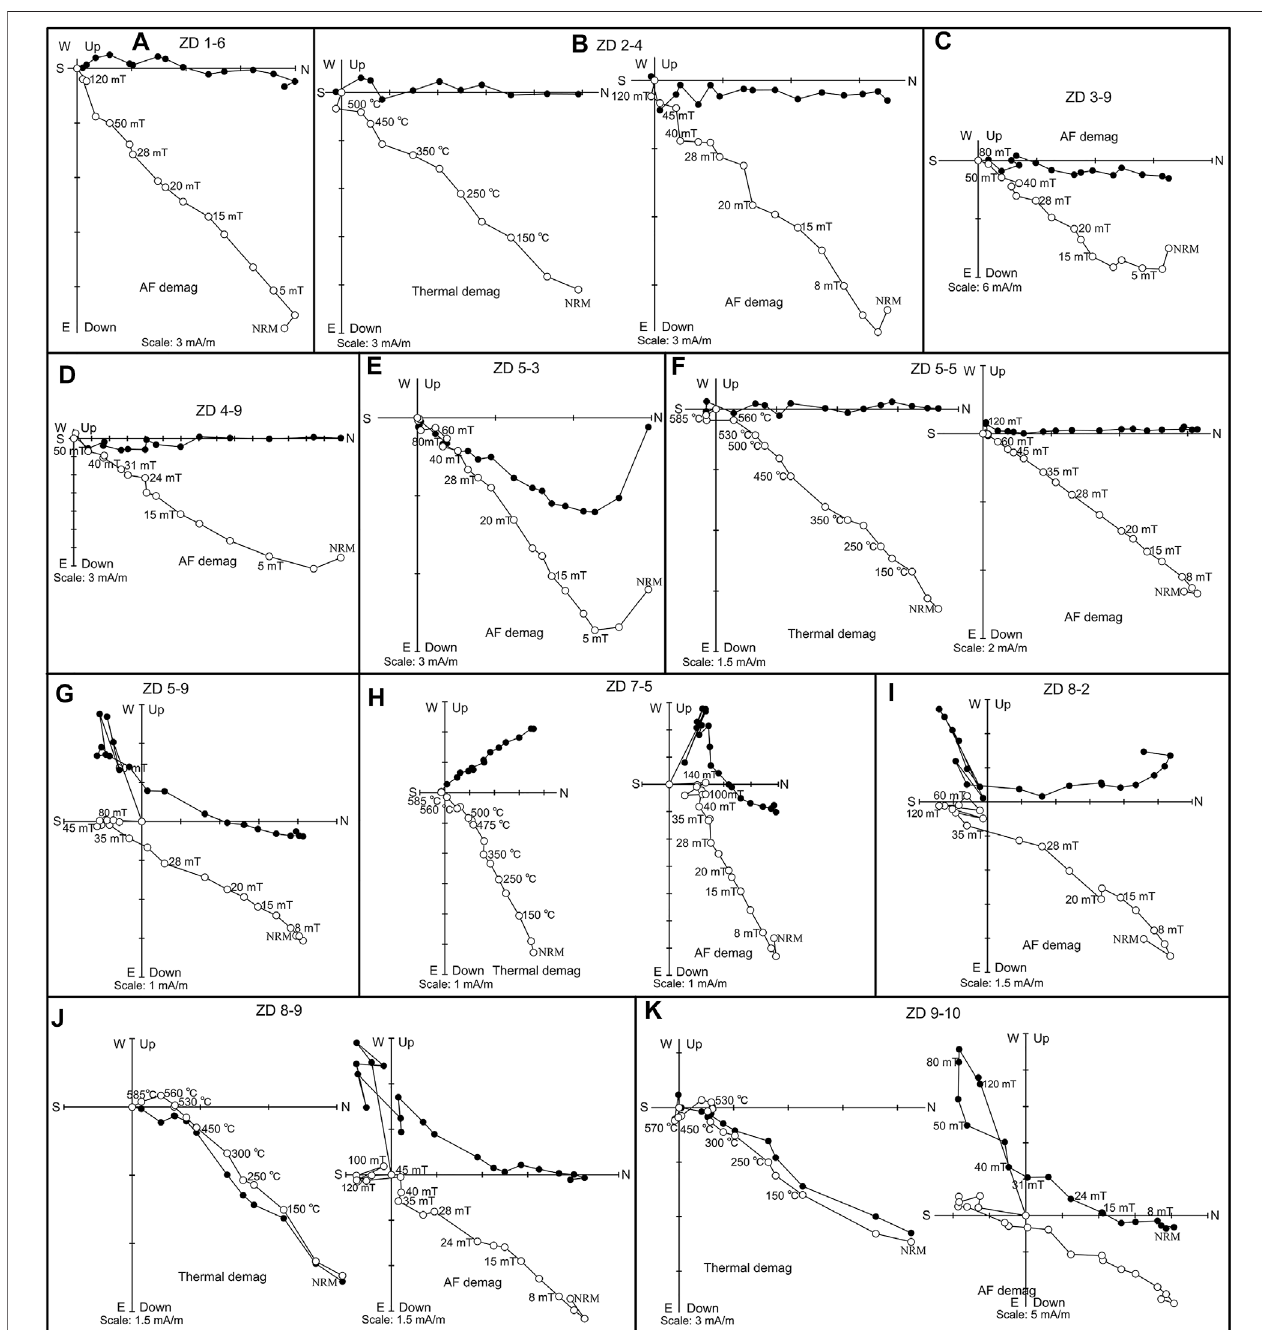
FIGURE 7 | (A – K) Zijderveld diagrams (Zijderveld, 1967) of the representative granite samples (in geographic coordinates). Solid (open) symbols represent the projections of vector endpoints on the horizontal (vertical) plane. Numbers along the inclination represent the alternating fi eld and thermal demagnetization steps in mT and ° C, respectively. AF demag: alternating fi eld demagnetization; Thermal demag: thermal demagnetization.